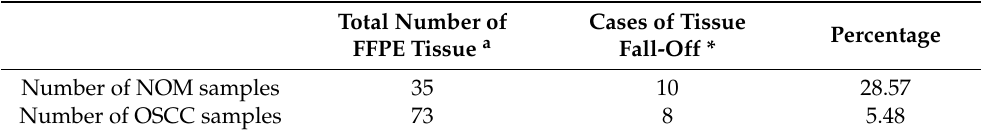
Table 1. Documentation of cases of tissue section fall-off from slides during sample processing steps for histochemical staining experiments for a period of 1 year (2019–2020) for FFPE tissues from the tissue bank of GNIDSR.